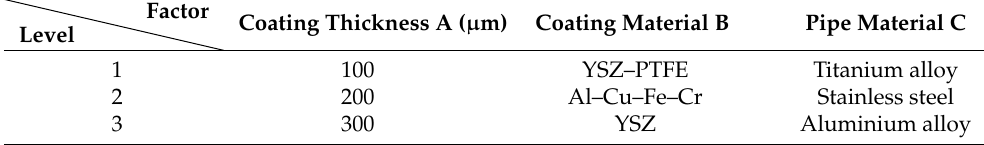
Table 1. Horizontal factor table.